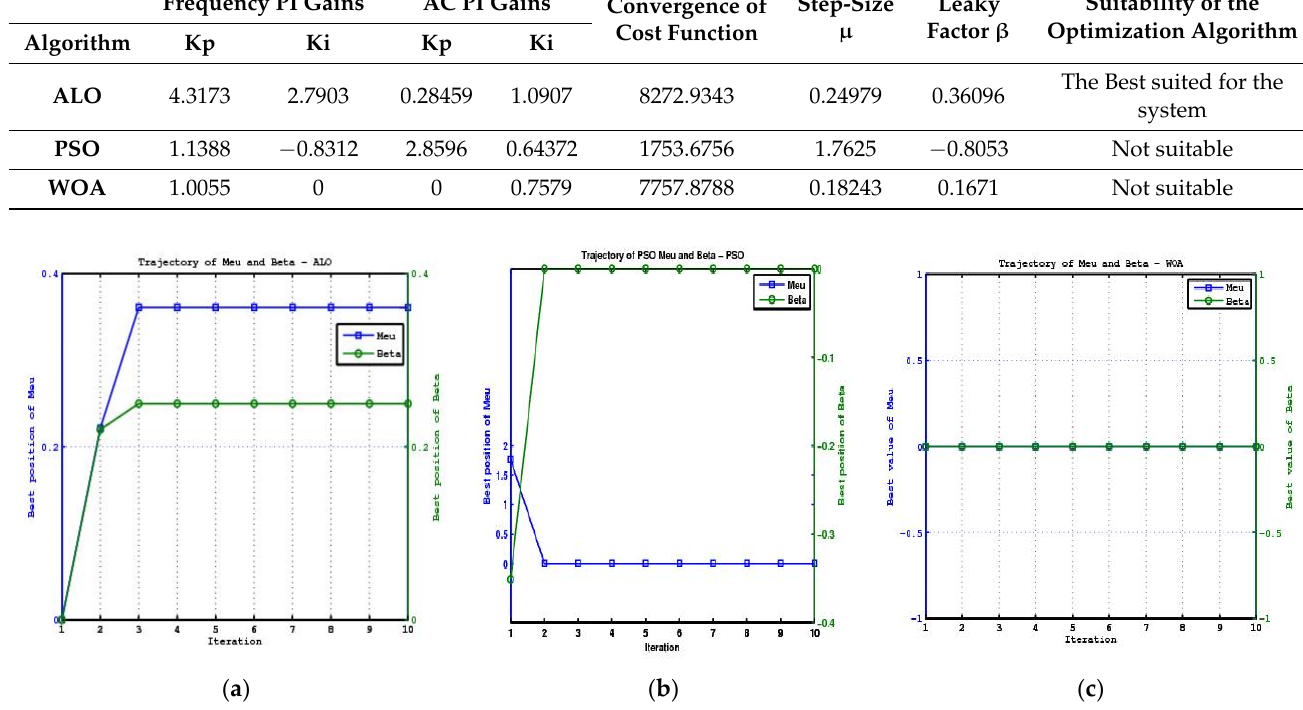
Figure 7. ( a ) Trajectory step size and leaky factor using ALO, ( b ) Trajectory step size and leaky factor using PSO and ( c ) Trajectory step size and leaky factor using WOA algorithm.